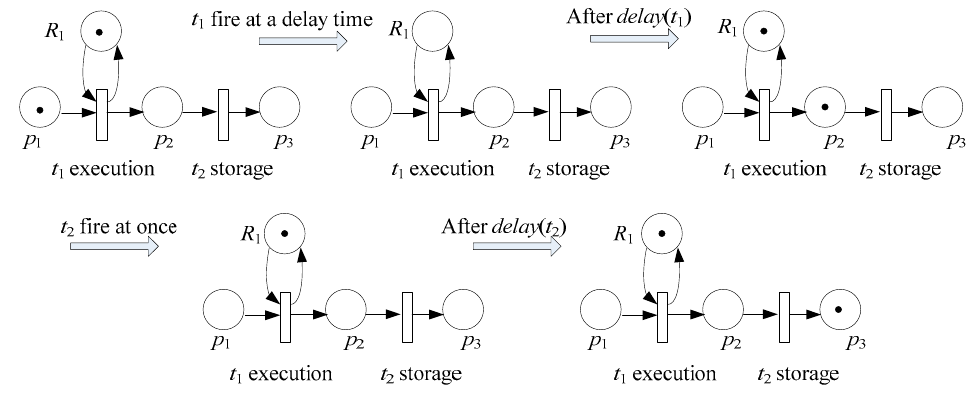
Figure 3. Structure of a PN with an execution and its successive storage.